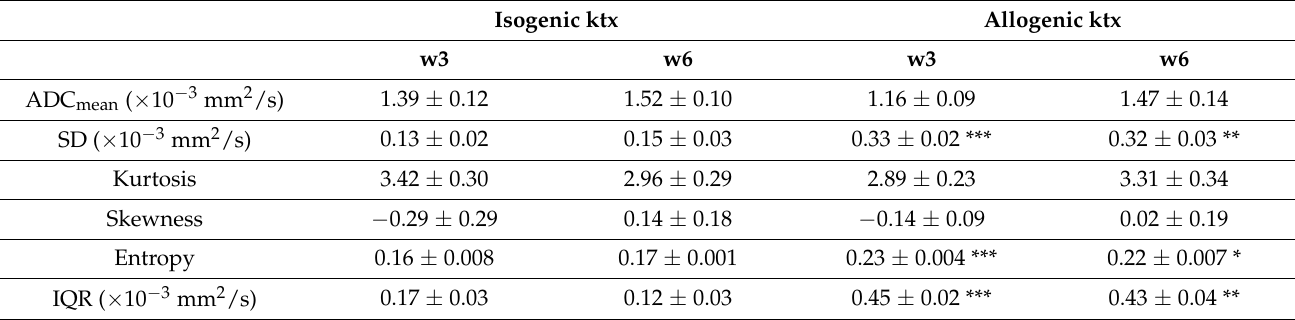
Figure 3. Apparent diffusion coefficient (ADC) of renal tissue after ktx. Representative ADC maps of a normal control kidney, isogenic and allogenic kidney grafts at week 3 (w3) and week 6 (w6) after transplantation are shown ( A ). Image size, window level and width are similar. Means ± SEM of ADC-values in the cortex and the outer medulla (OM) are given ( B ). Note the obvious heterogeneity of the renal tissue in the ADC map after allogenic ktx compared to the homogeneously parenchyma in the isografts. Table 2. Histogram analysis of the ADC after isogenic and allogenic kidney